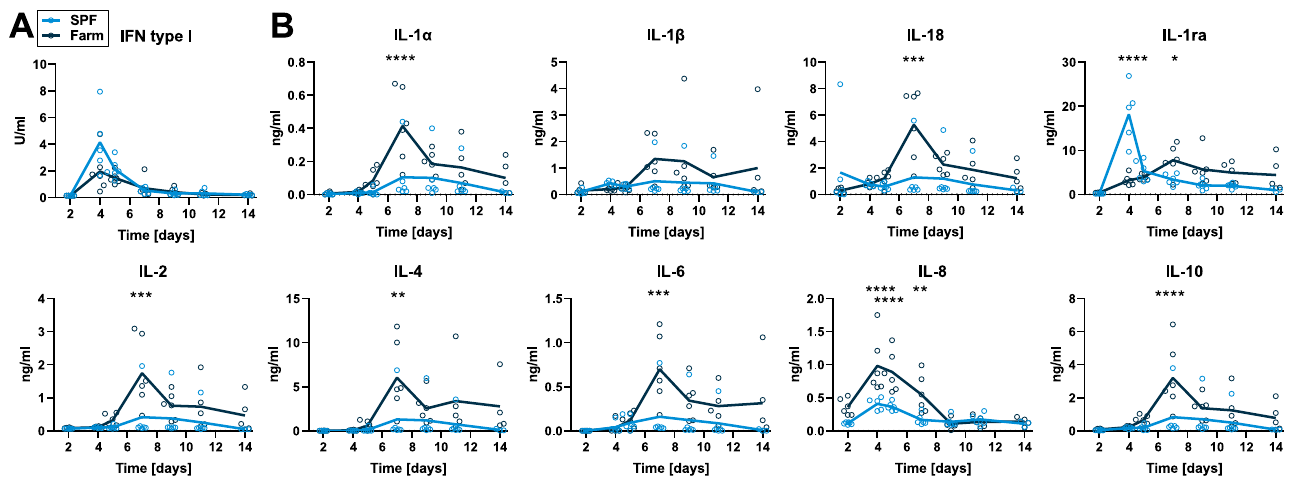
Fig 8. Serum cytokines after infection with attenuated ASFV Estonia 2014. Blood samples were taken on 2, 4, 5, 7, 9, 11, and 14 dpi. (A) IFN type I activity in serum was measured by bioassay. (B) Cytokine levels were determined by multiplex ELISA. Data points show values for individual animals and lines indicate mean of each group at indicated dpi. Differences between SPF and farm groups were analyzed by unpaired t test at each dpi with Holm-Sidak’s correction for multiple comparisons (n = 6 pigs/group, except on 14 dpi, where n = 5 for farm group). � p < 0.05, �� p < 0.01, ��� p < 0.001, ���� p < 0.0001.